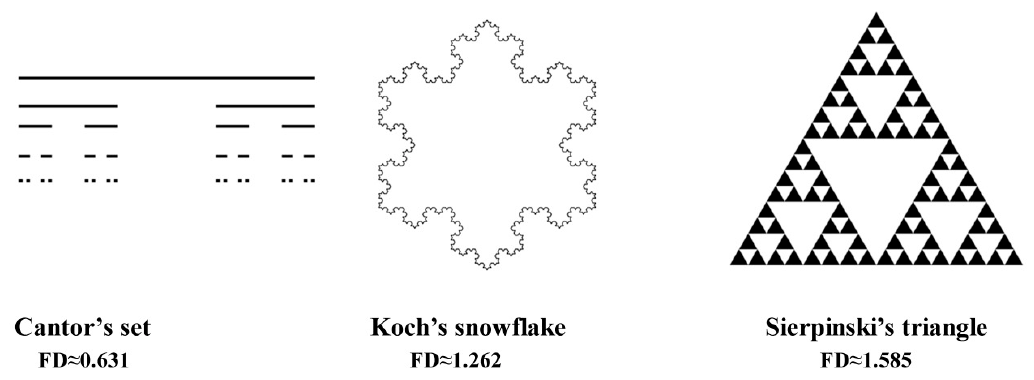
Figure 1. Examples of classical fractal and their fractal dimension value.